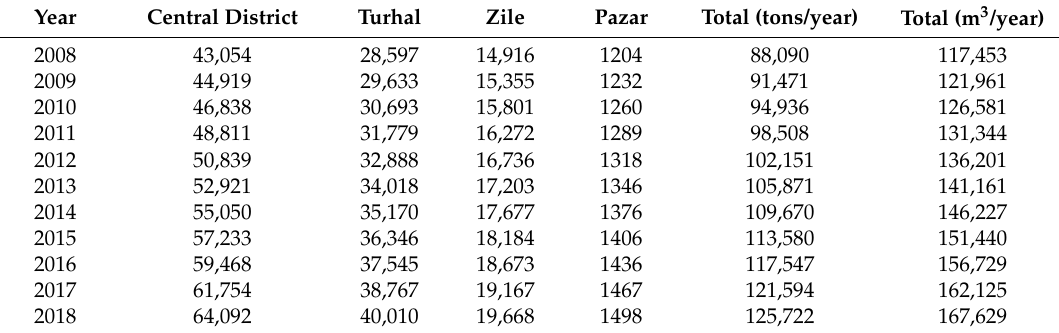
Table 5. Predicted statistics in the EIA report regarding the amount of solid waste to be stored.